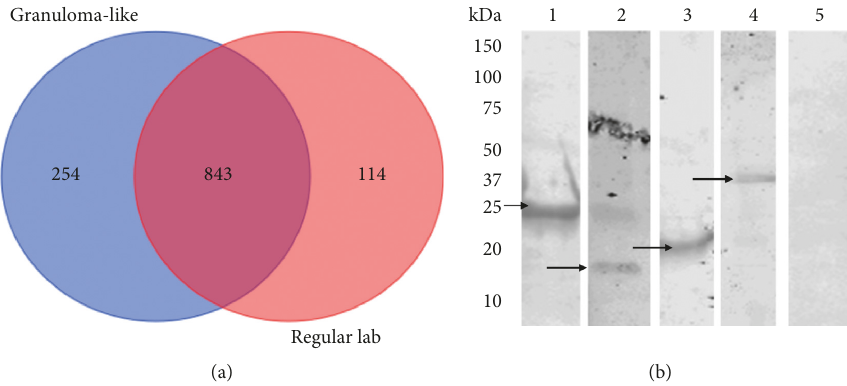
Figure 2: M. bovis BCG surface proteins expressed in different conditions. (a) Venn diagram showing the number of overlapping and unique set of bacterial surface proteins synthesized in granuloma-like and regular lab conditions. (b) Western blotting of M. smegmatis cell lysate overexpressing Mb1524, Mb01_03198, PhoU1, and hbhA proteins using anti-His monoclonal antibody. Lane 1, pMV261- PhoU1; Lane 2, pMV261-Mb01_03198; Lane 3, pMV261-hbhA; Lane 4, pMV261-Mb1524; Lane 5, pMV261 control. Arrows indicate expressed proteins.